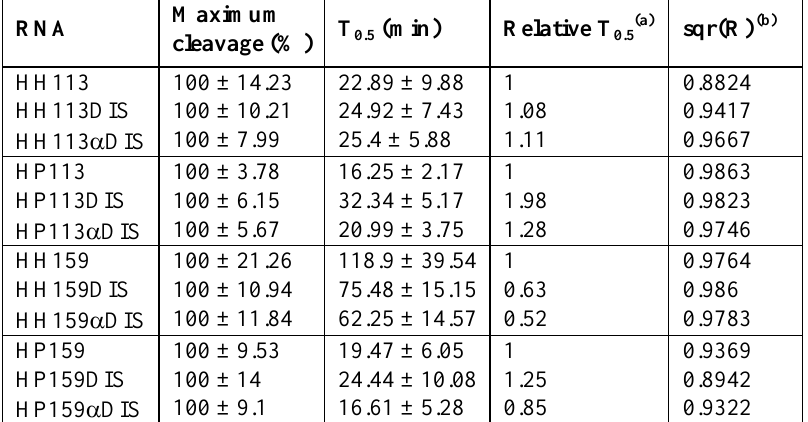
Table 1. In vitro c leavage reactions of the HIV-5’ UTR by catalytic RNAs. (a) T were normalized to the one of the corresponding ribozyme. (b) Regression curves were fixed to a maximum cleavage value of